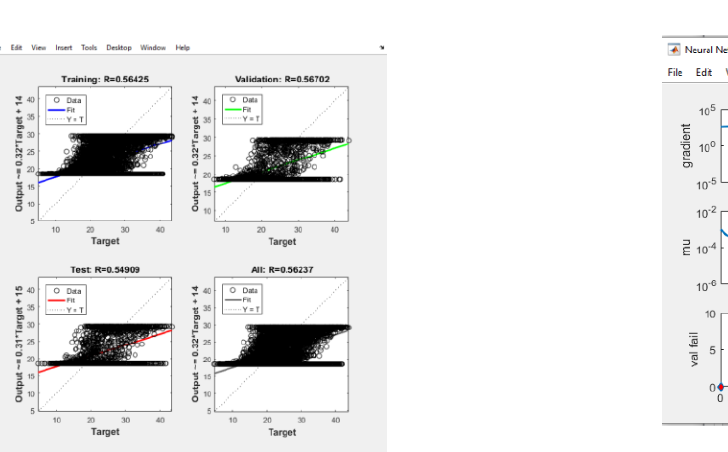
Figure 15 . The three plots represent the training, validation, and testing data. The dashed line in each plot represents the perfect result – outputs = targets. The solid line represents the best fit linear regression line between outputs and targets. The R value is an indication of the relationship between the outputs and targets. If R = 1, this indicates that there is an exact linear relationship between outputs and targets. If R is close to zero, then there is no linear relationship between outputs and targets.